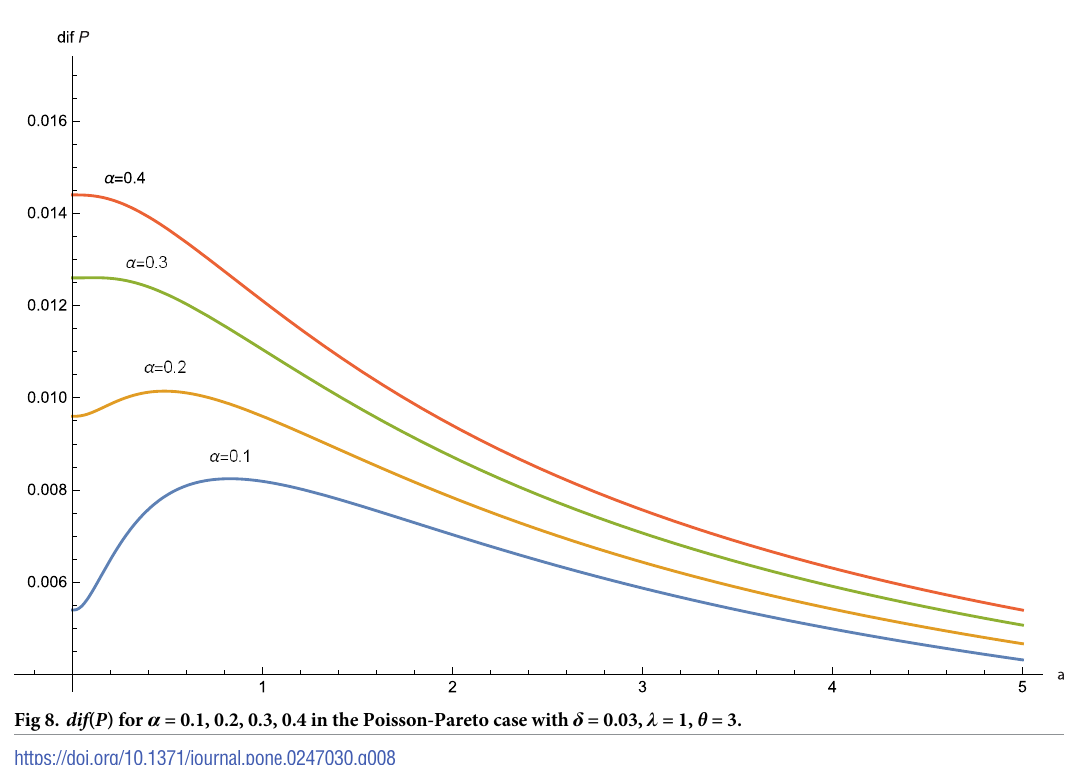
Fig 8. dif ( P ) for α = 0.1, 0.2, 0.3, 0.4 in the Poisson-Pareto case with δ = 0.03, λ = 1, θ = 3.